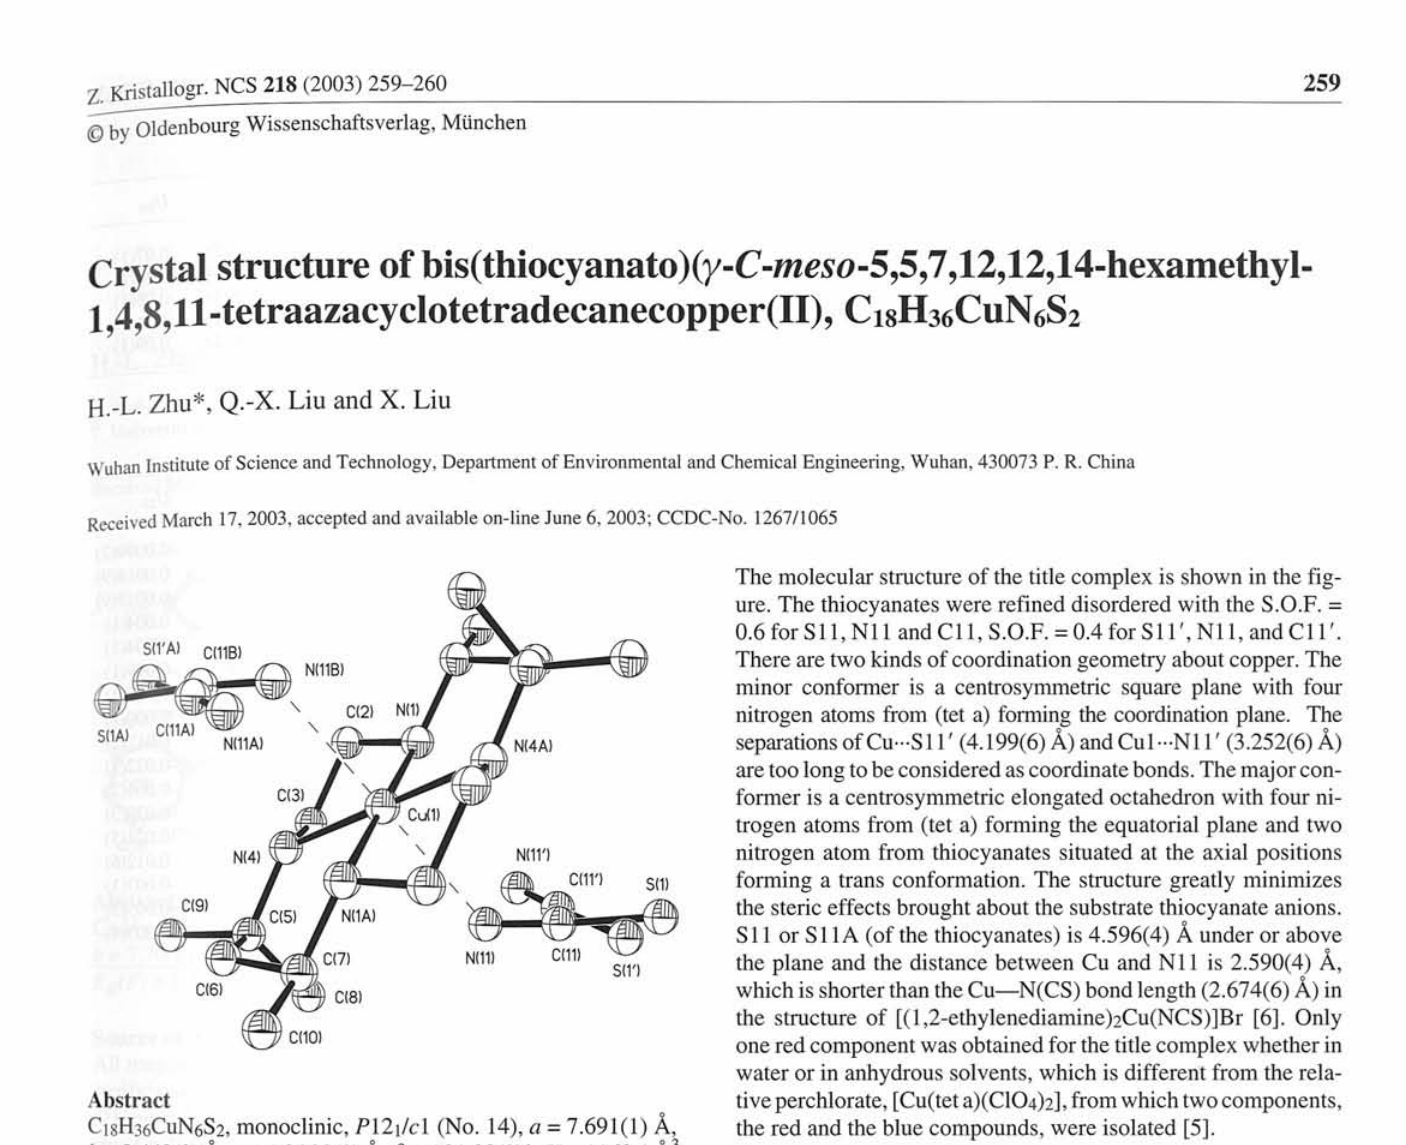
Table 1. Data collection and handling.